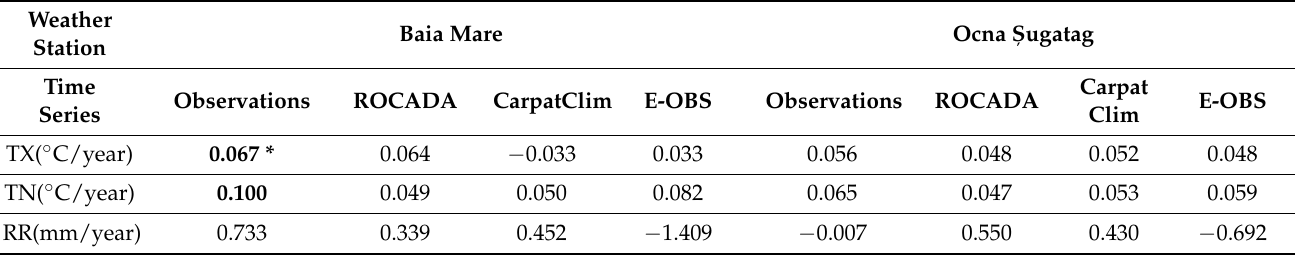
ugatag weather stations. ,